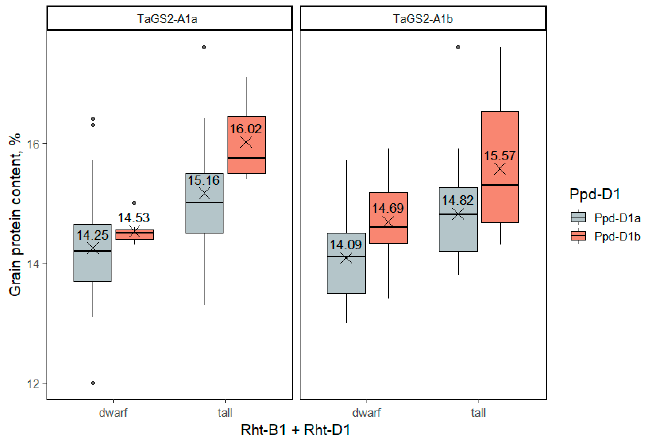
Figure 8. Grain protein content (%) in winter wheat accessions differing in Rht-1 , Ppd-D1 and TaGS2-A1 genotypes. The dots indicate outliers.